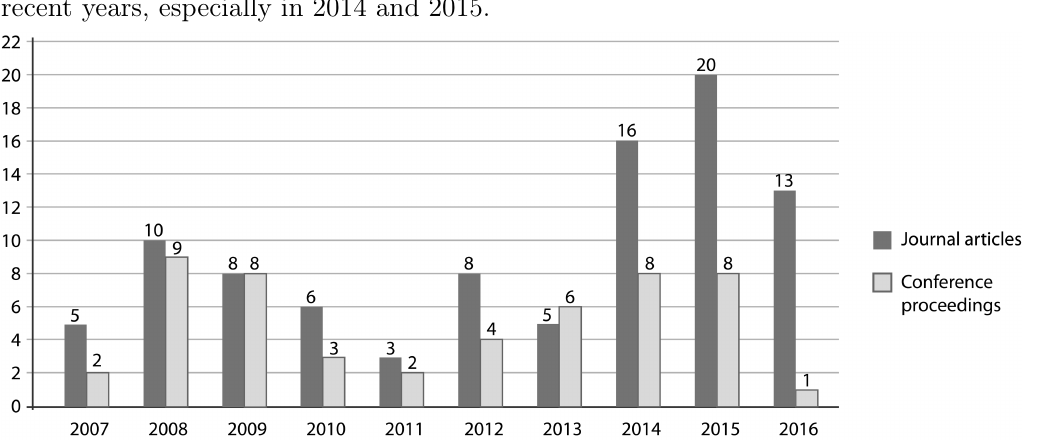
Fig. 1. Distribution of the selected papers over the period 2007–2016.